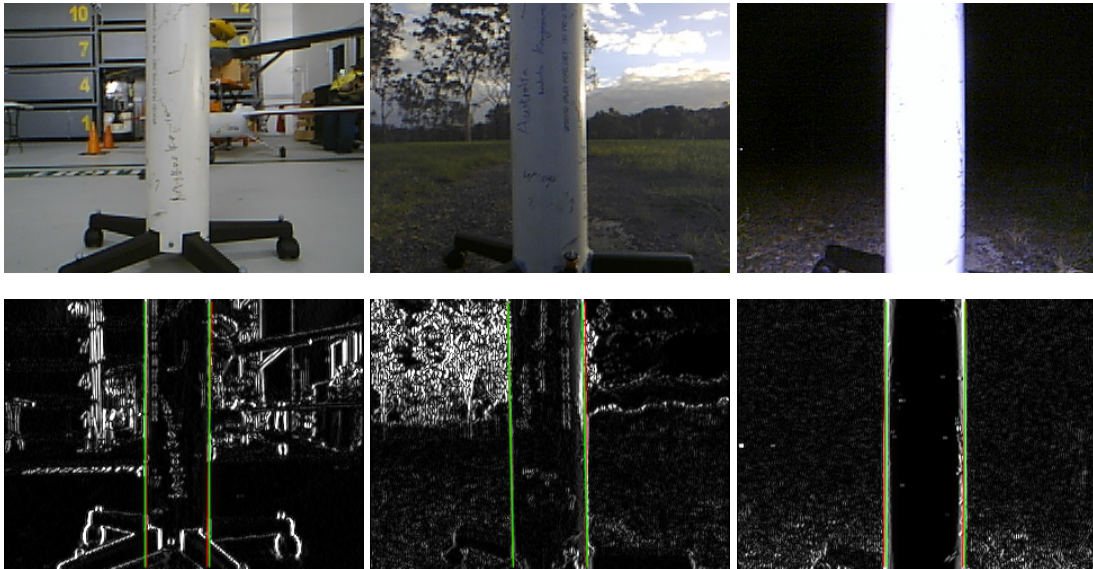
Figure 18. Sample onboard images from the three hovering test environments: indoor ( left ), day-time outdoor ( mid ) and night-time outdoor ( right ) respectively. The top row contains the raw images while the bottom row contains the corresponding gradient images with overlaid lines corresponding to the goal line positions (green) and the tracked pole edges